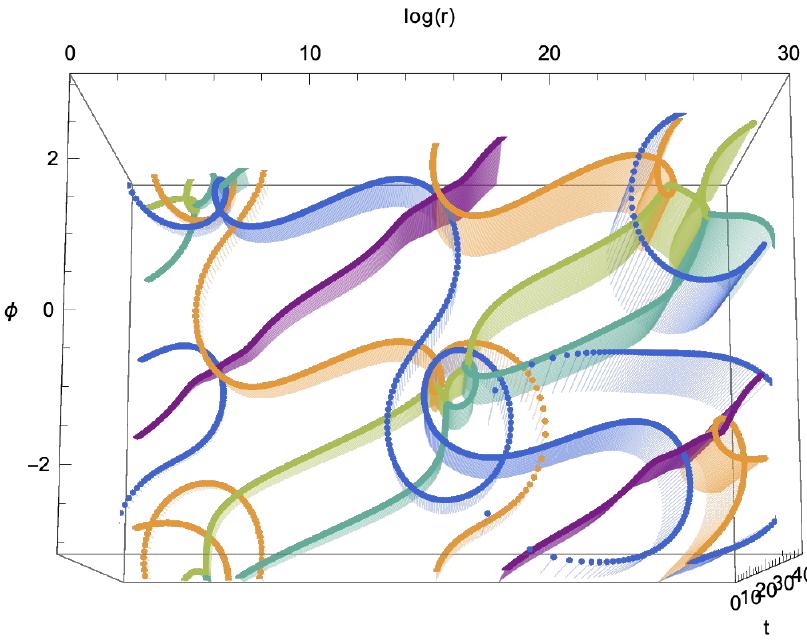
Figure 2 . Dynamics of the (cid:12)shchain consisting of J = 4 particles (denoted by di(cid:11)erent colours). The initial conditions are restricted to a 2 D plane after projection on the boundary. The plane is parametrized in the radial parameters by the angle (cid:30) and the radius r . The third axis corresponds to the time. The drift in (cid:30) is due to a non-zero total angular momentum S and the exponential expansion in r is due to (cid:1) >